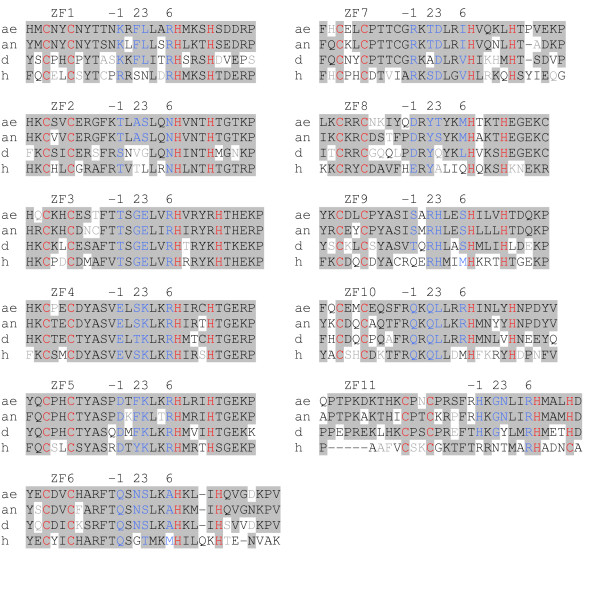
The zinc-finger (ZF) domain is highly conserved between humans and the dipteran insects, Ae. aegypti, An. gambiae and D. melanogaster. Each of the eleven ZFs were aligned using the ClustalW algorithm. Identical and highly conserved residues are highlighted in gray. Weakly conserved residues, the zinc-coordinating residues, and the amino acids with identical binding site recognition properties are indicated in gray, red and blue font respectively.